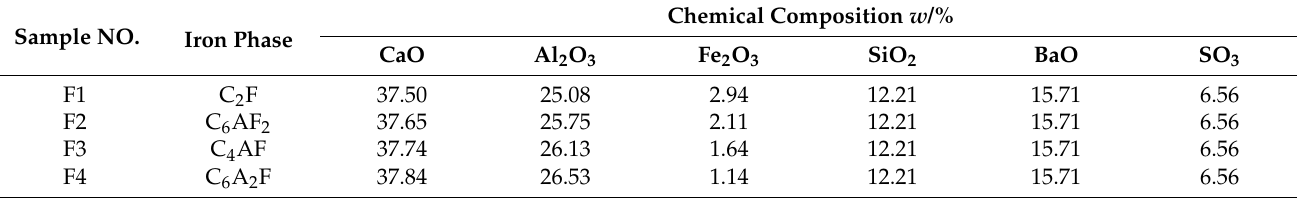
Table 1. Chemical composition of